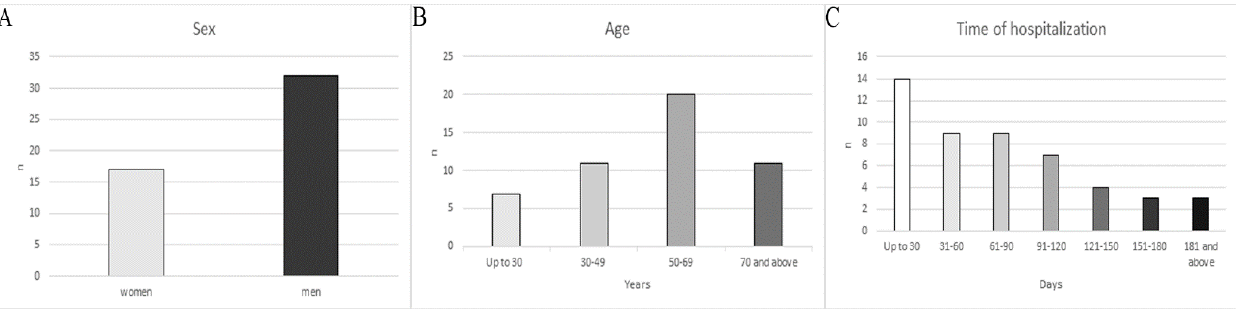
Figure 1. The number of patients diagnosed with nosocomial infections by sex (A), age (B) and time of hospitalization (C).